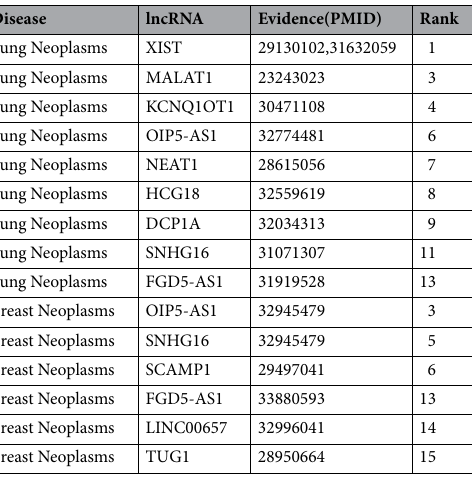
Table 2. Candidate lncRNAs and TWO rank in the top 15 of the TWO cases and the related